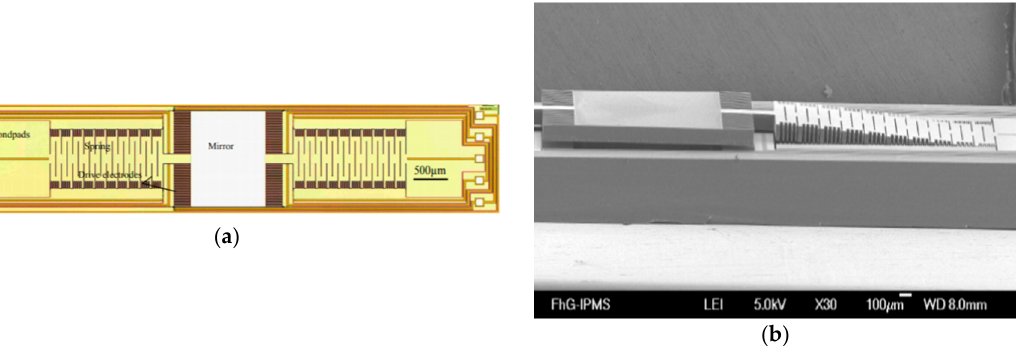
Figure 12. Layout ( a ) and SEM image ( b ) of a type A translational MEMS micromirror, using two long bending springs as mirror suspension. (Reprinted with permission from Reference [37] SPIE).